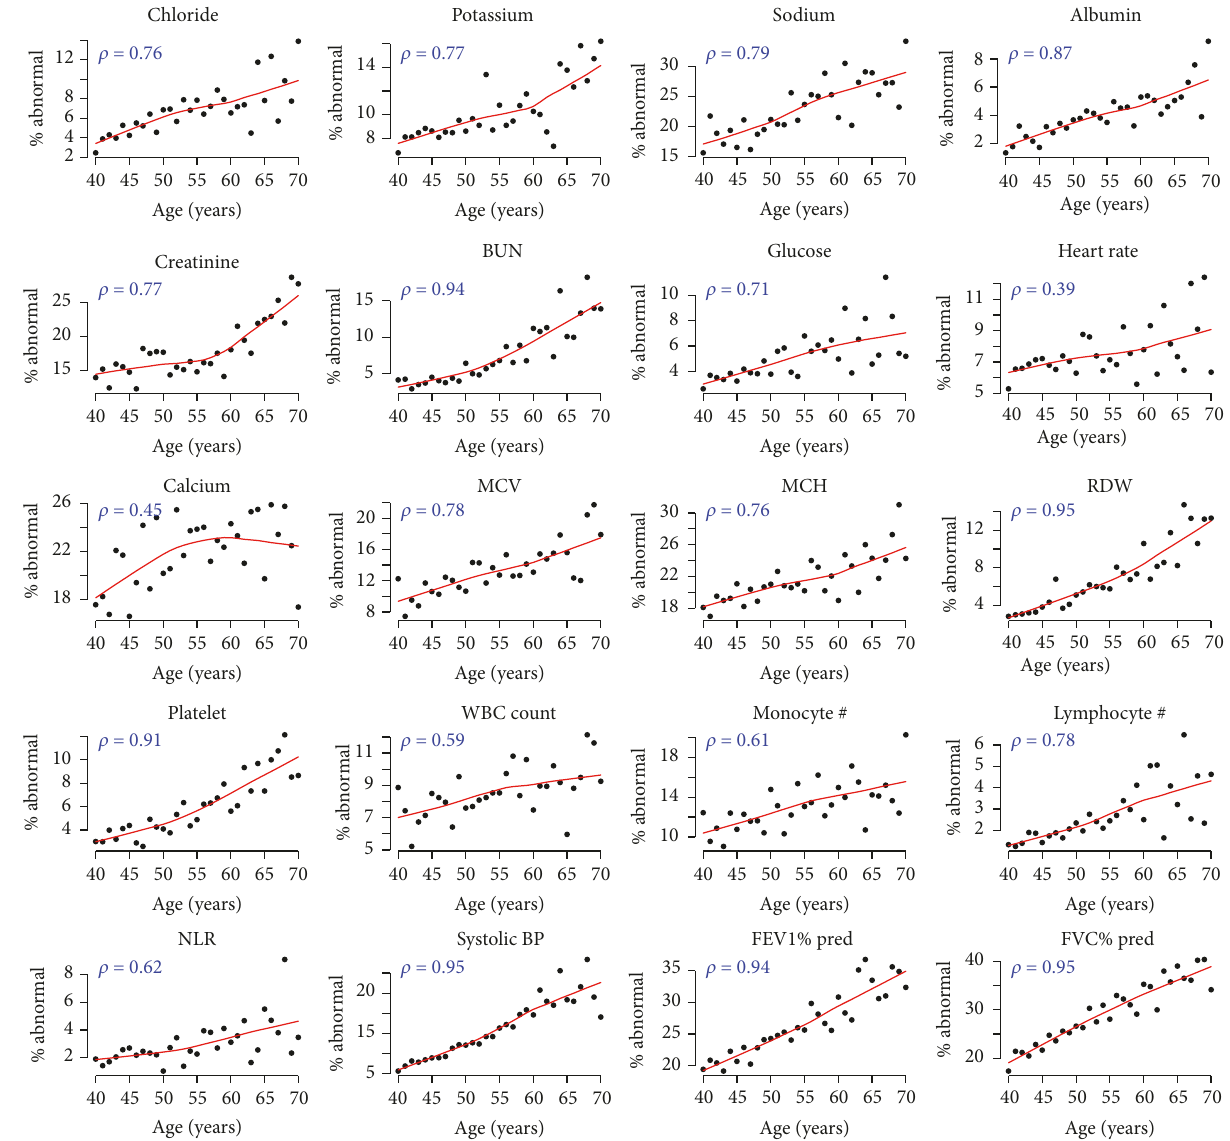
Figure 1: Plots depicting the rate of abnormal values of physiological parameters over ages 40–70. Each plot corresponds to one physiological parameter, with black dots representing raw data (% of individuals of a certain age with abnormal values on a physiological parameter). Smooth fits (solid red curve) were computed using locally weighted scatterplot smoothing (LOESS). Spearman correlation is provided on the top left corner of each plot. BUN: blood urea nitrogen; MCV: mean corpuscular volume; MCH: mean corpuscular hemoglobin; RDW: red cell distribution width; WBC: white blood cell; NLR: neutrophil-to-lymphocyte